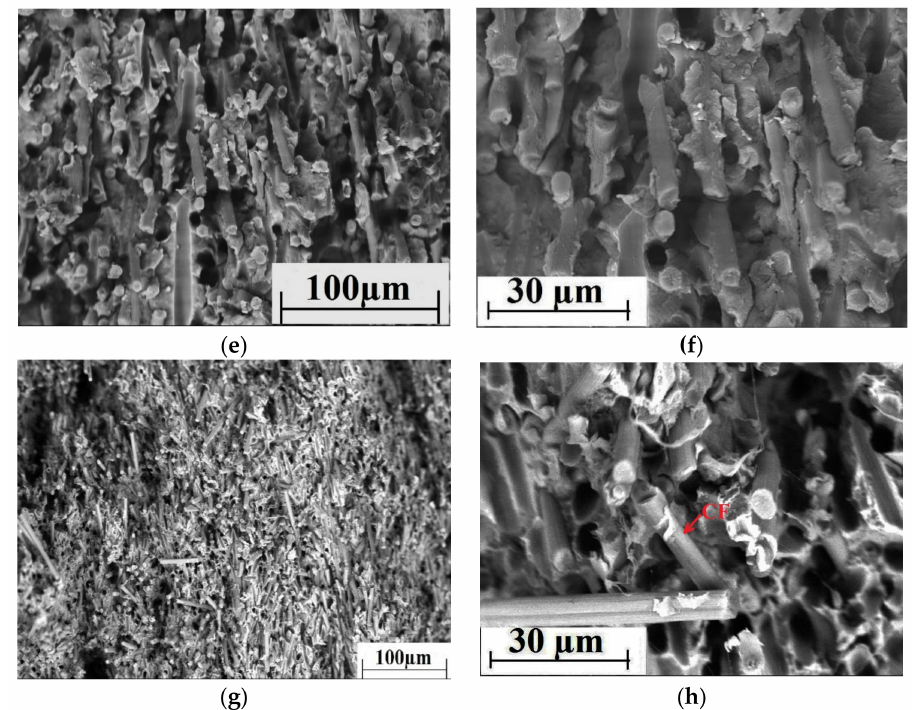
Figure 8. SEM micrographs of the permolecular structure: ( a , b ) PPS, ( c – h ) the PPS-based composites (( c,d ) PPS + 15% PTFE, ( e,f ) PPS + 20% CF, ( g,h ) PPS + 15% PTFE + 22.5% CF).